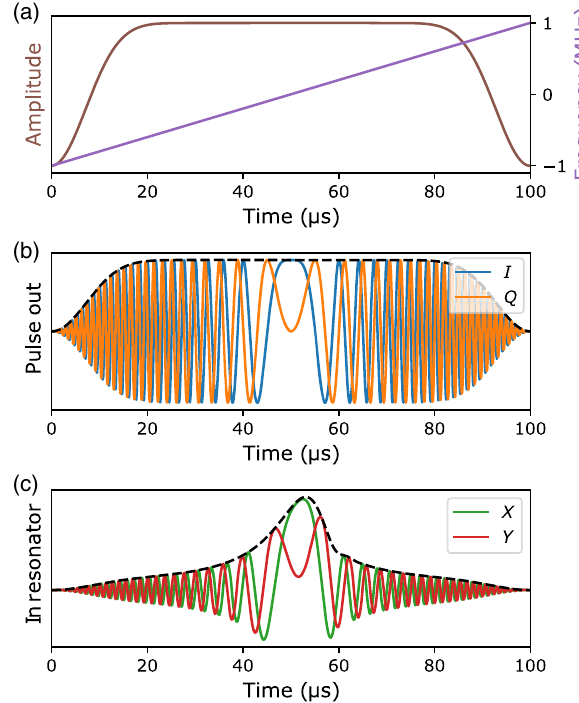
FIG. 12. WURST-20 pulses with (a) the pulse amplitude and frequency shift for a WURST pulse with bandwidth 2 MHz and duration 100 μ s. (b) The I and Q quadratures of the same WURST pulse. (c) The X and Y field quadratures in the cavity once the WURST pulse is filtered by a κ ¼ 200 kHz cavity.